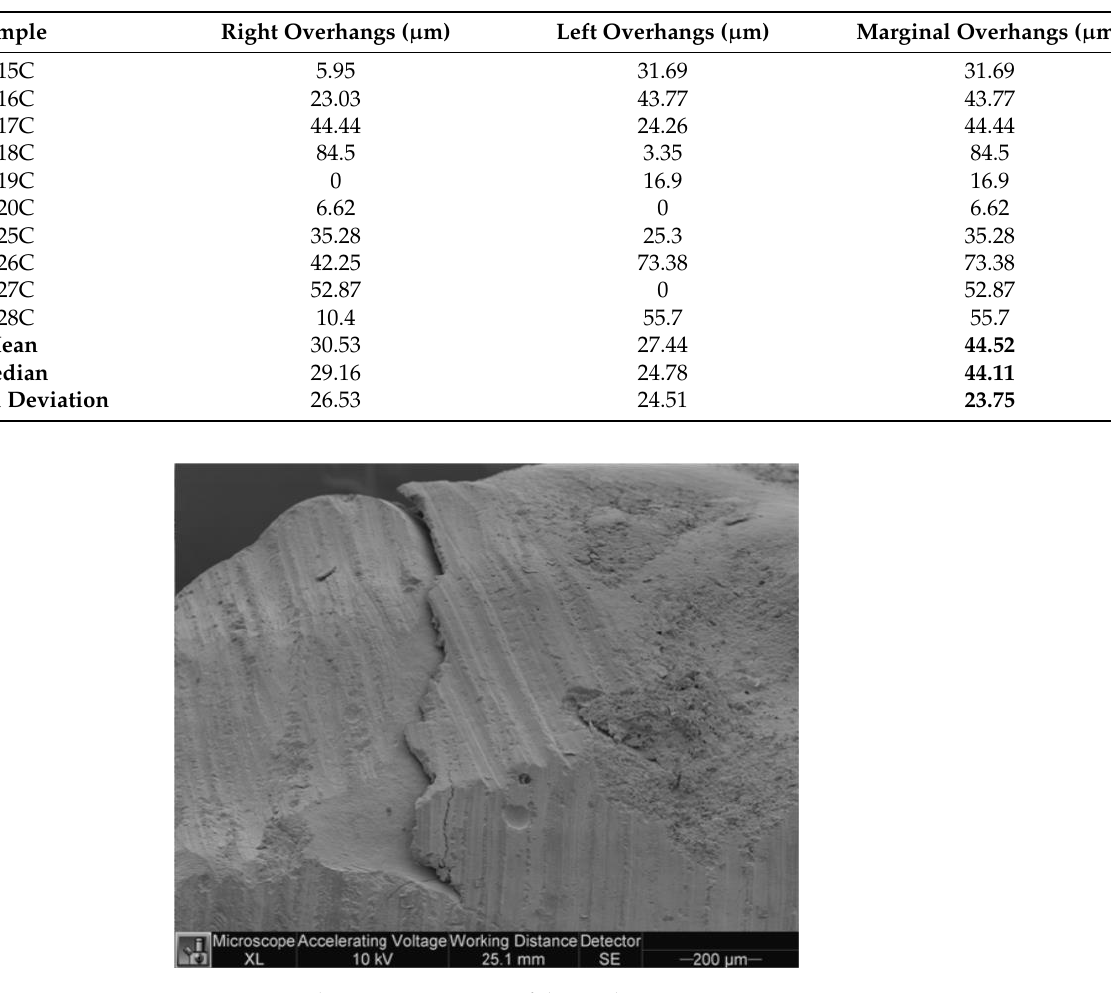
Table 6. Overhangs in the control group.